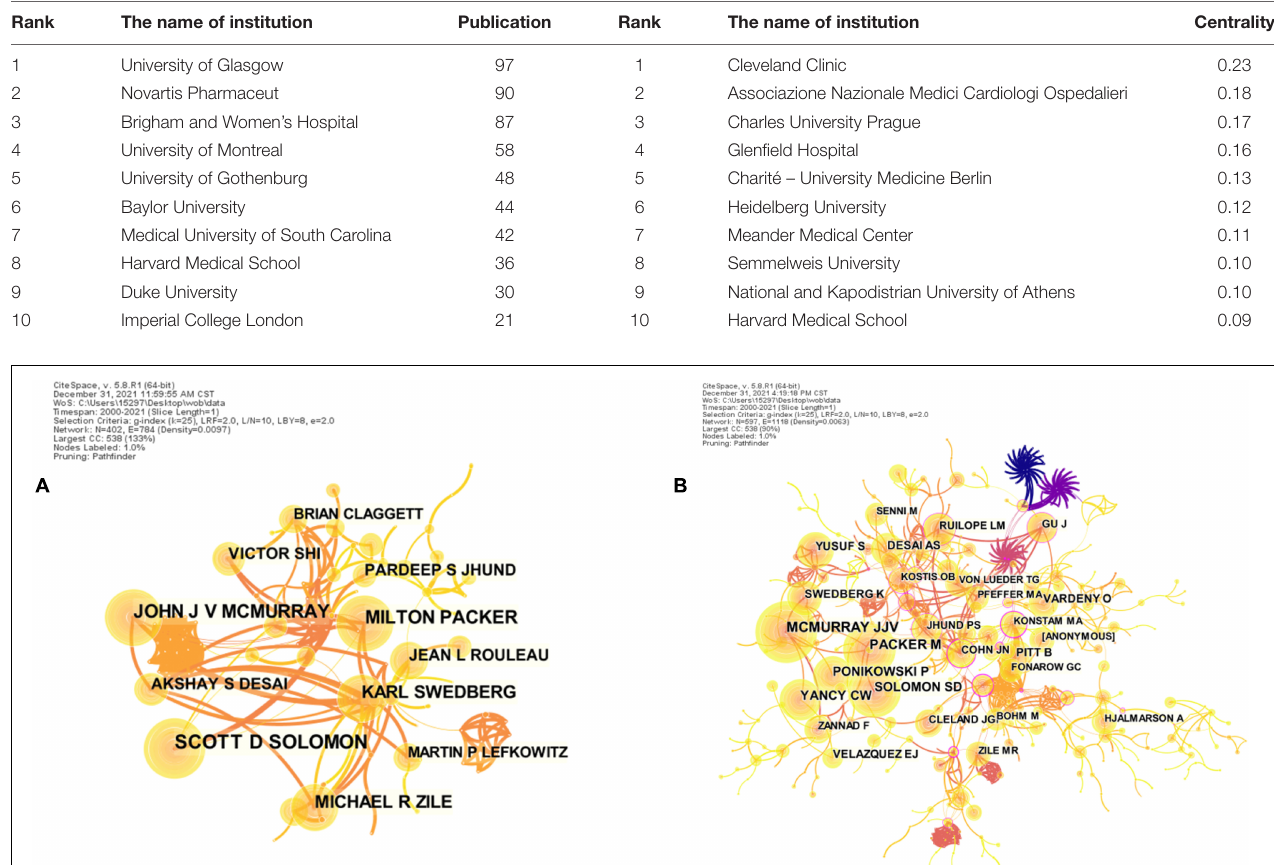
TABLE 2 | Top 10 institutions involved in ARNI cardiovascular system research in terms of volume and centrality of publications.